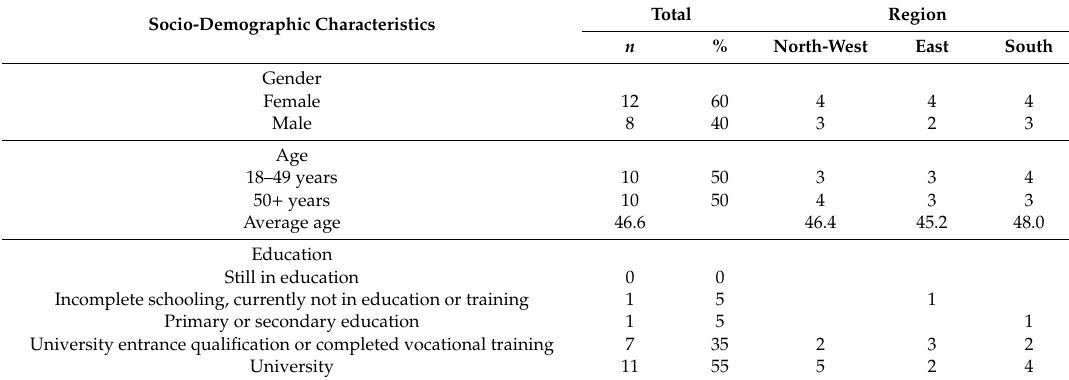
Table 1. Socio-demographic characteristics of the study participants ( n =